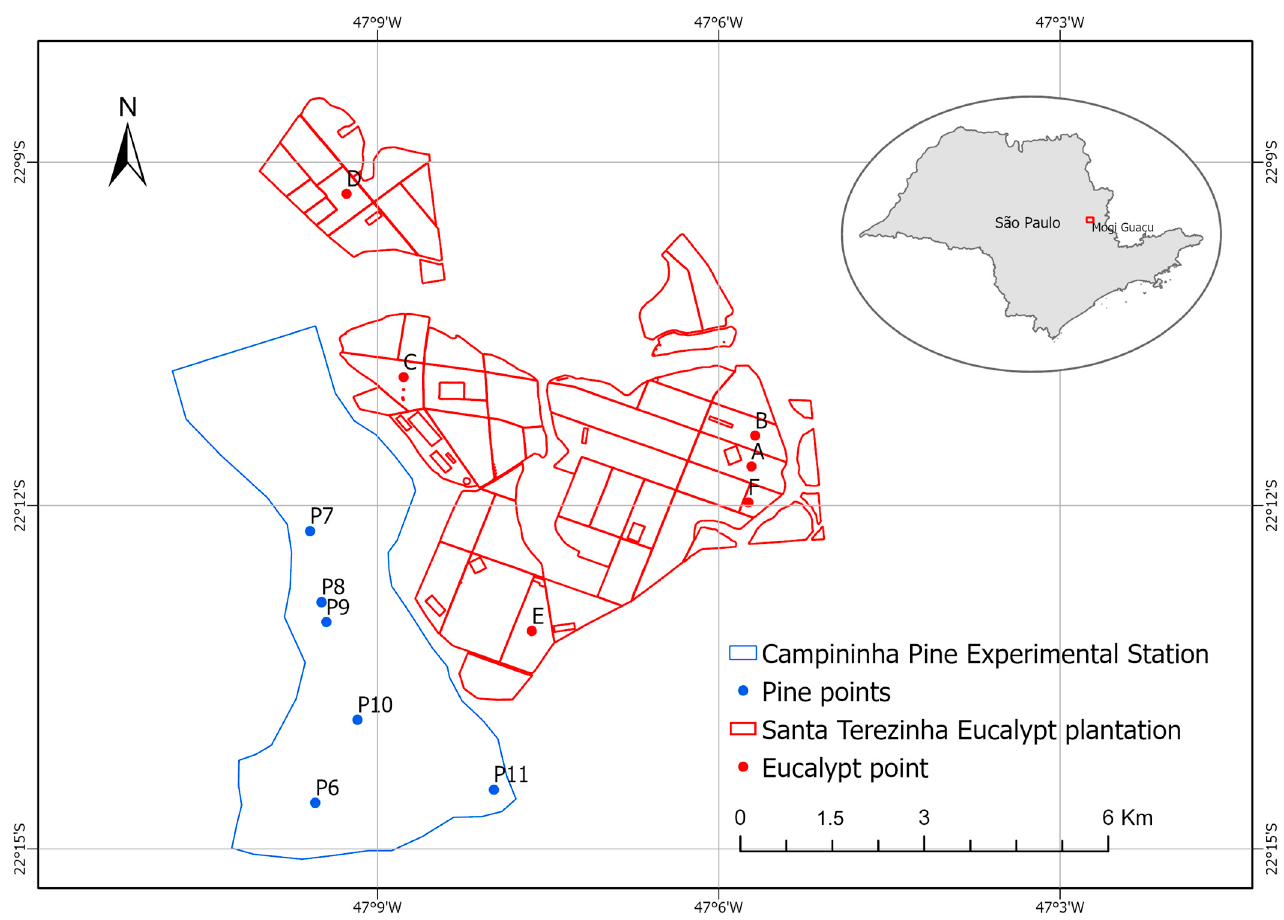
Figure 2. Location of the pilot area within the municipality of Mogi Guaçu, in São Paulo State. The sample points are highlighted in the figure.